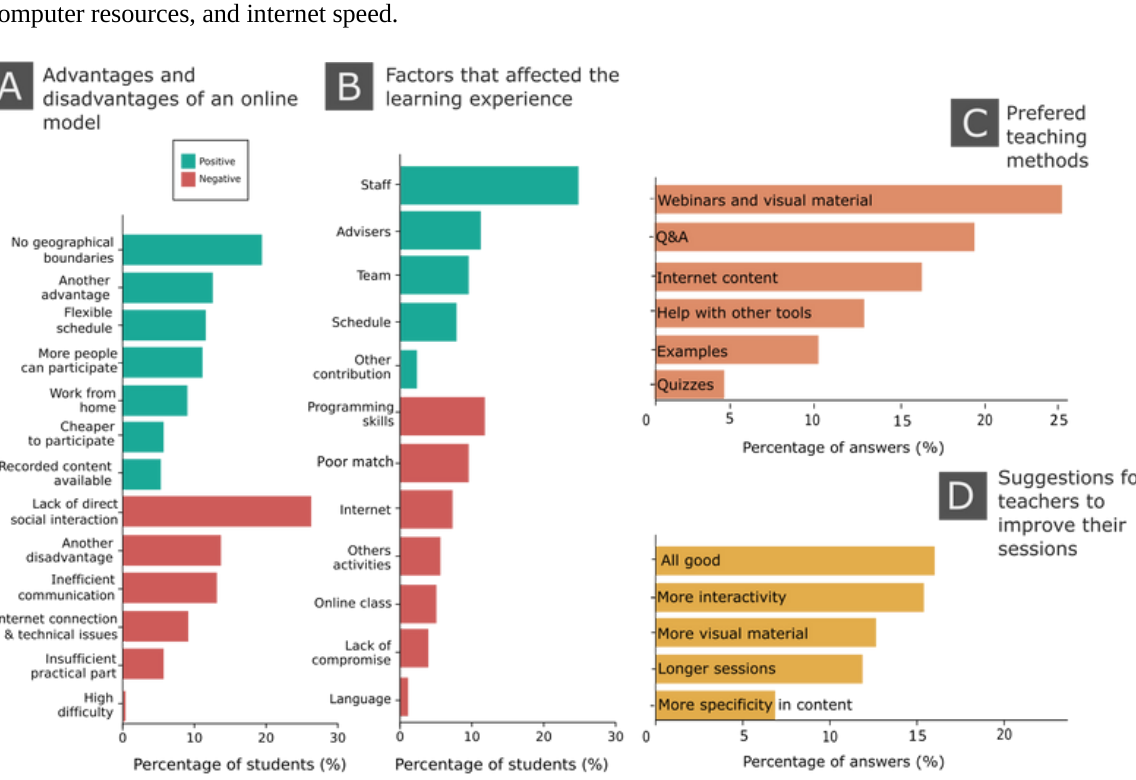
Figure 4. Summary of exit survey answers [1] evaluating students’ assessment of the program (187 responses). A) Top advantages and disadvantages of an online model from students' answers. B) Summary of the factors that affect students’ learning experience,